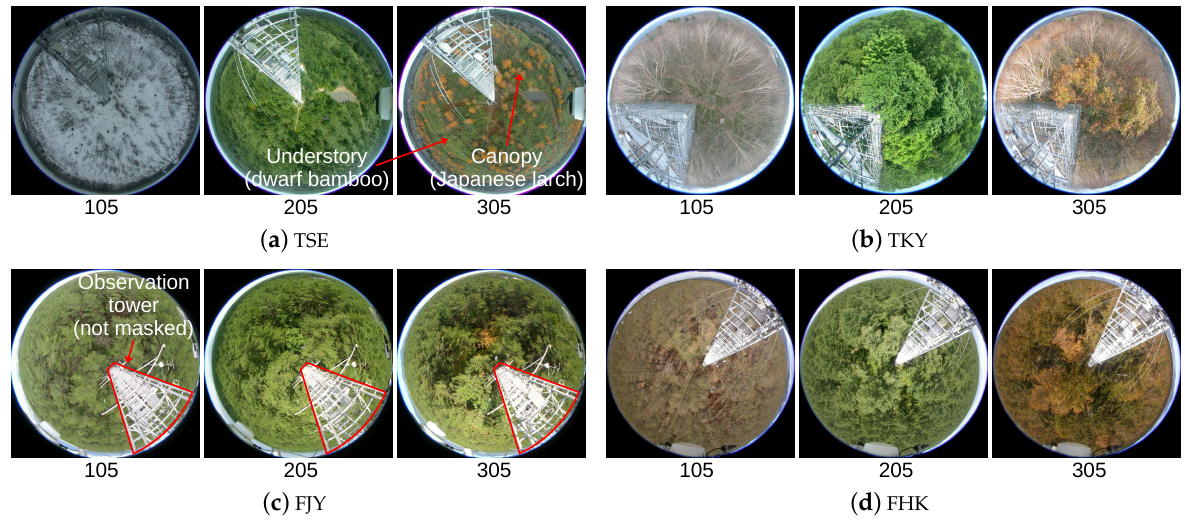
Figure 19. The downward fisheye images taken by ADFC in 2018 at ( a ) TSE, ( b ) TKY, ( c ) FJY, and ( d ) FHK. The numbers under the images are DOY when the images were taken. The images approximately display the approximately same observation area as downward MS-700 for each